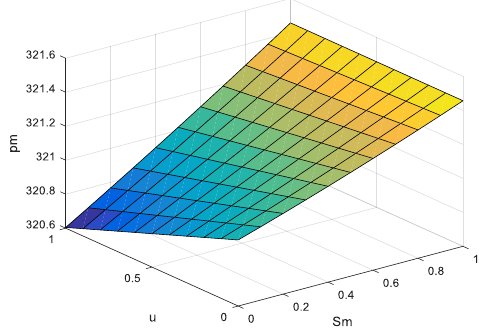
Figure 2. Effect of s m and µ on p m .